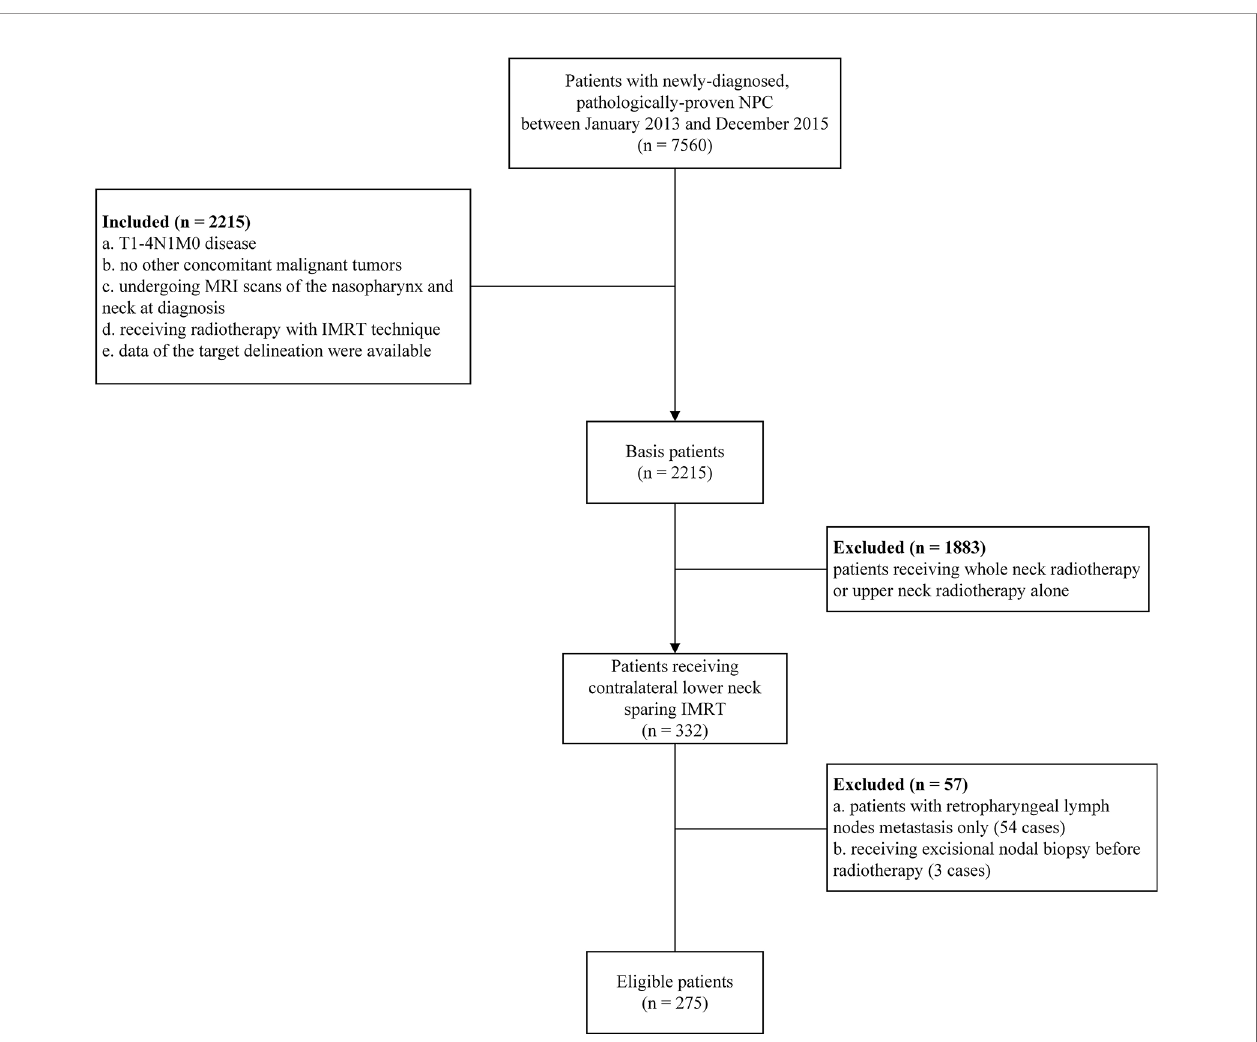
FIGURE 2 | Flowchart of the patients included in the